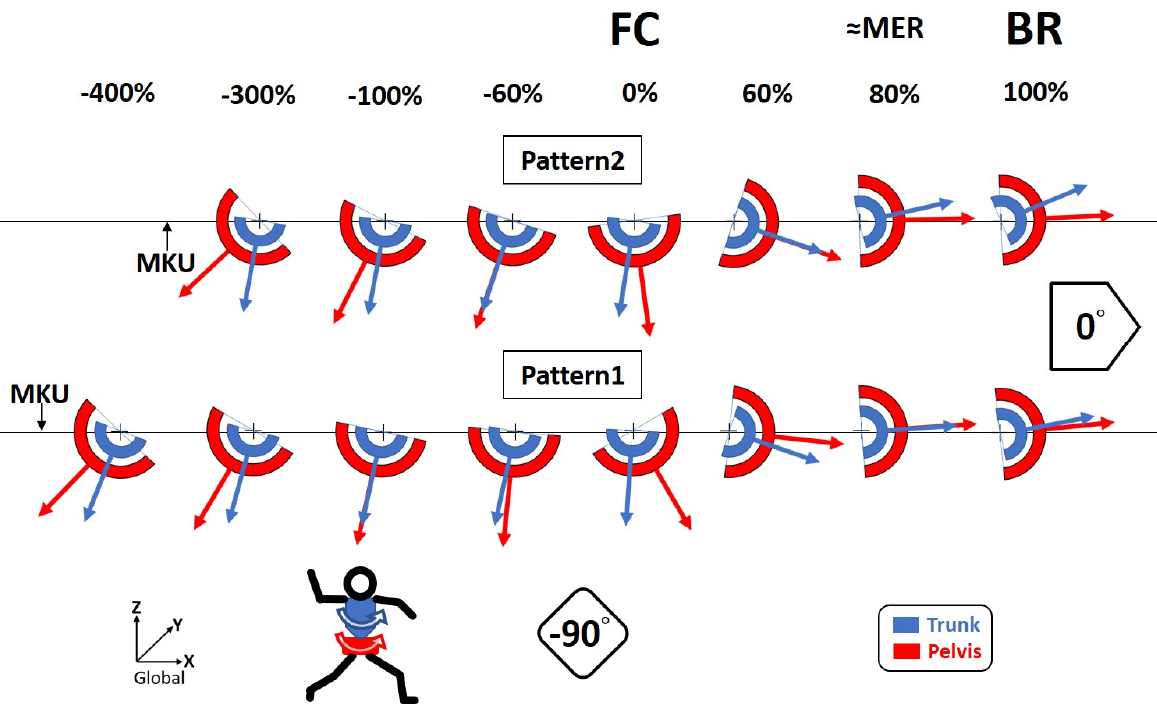
Figure 2. A schematic diagram comparing Pattern1 and Pattern2 viewing in the transverse plane at different time ratios. The kinematic definition of pelvic and trunk axial rotation is in relation to global coordinate system. In the transverse plane, rotation towards the home plate is defined as 0 ◦ , whereas that towards third base is defined as − 90 ◦ . MKU = maximum-knee-up; FC = foot contact; MER = maximum -shoulder-external-rotation; BR = ball-release.